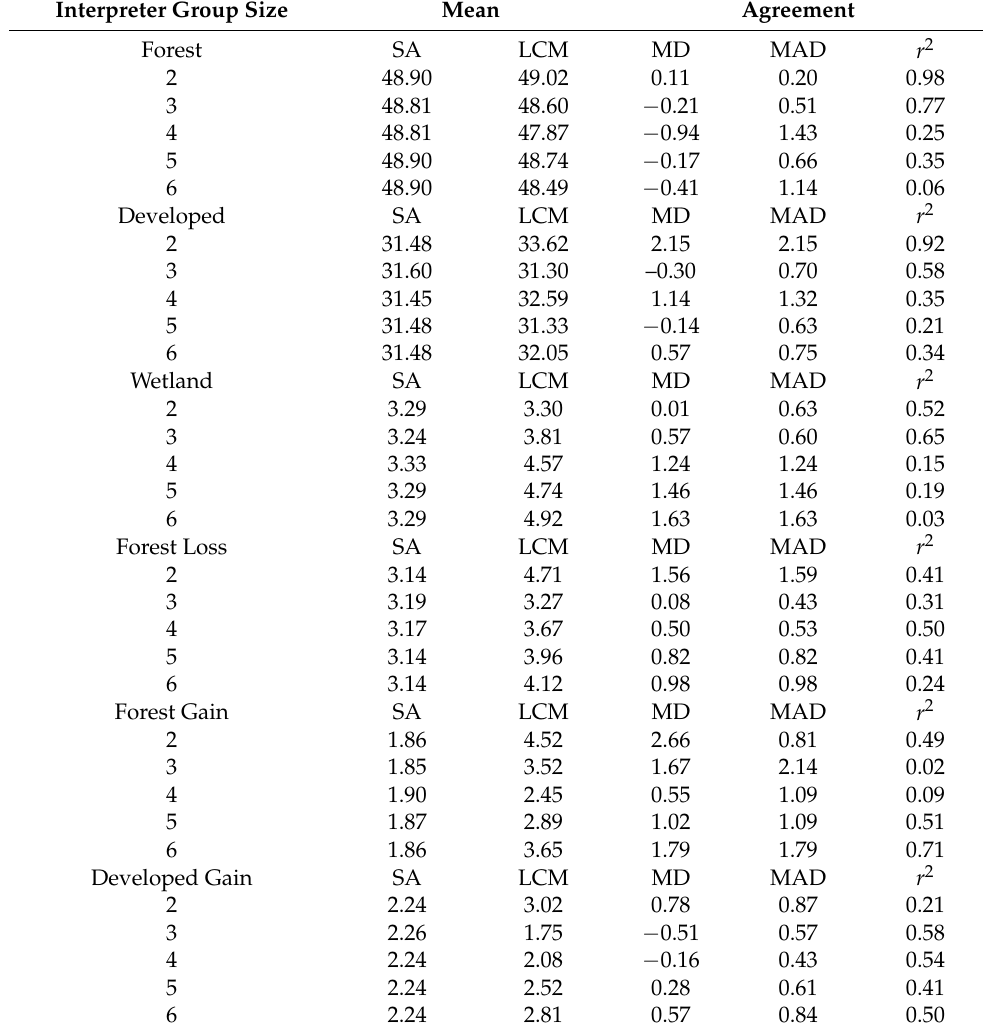
Table 5. Mean estimated percent area of SA and LCM and agreement between SA and LCM over different interpreter subsets within each interpreter group size for 2010 land cover and 2000–2010 land cover change (MD = mean difference and MAD = mean absolute